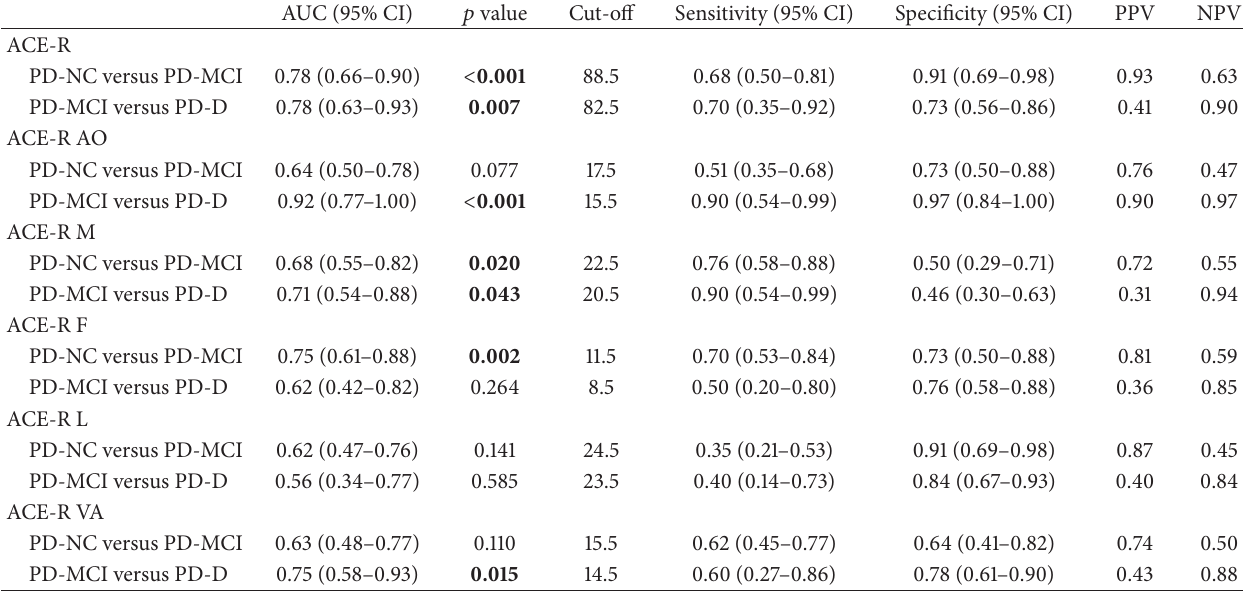
Table 2: AUC estimates calculated in ROC analyses and ROC characteristics at optimal